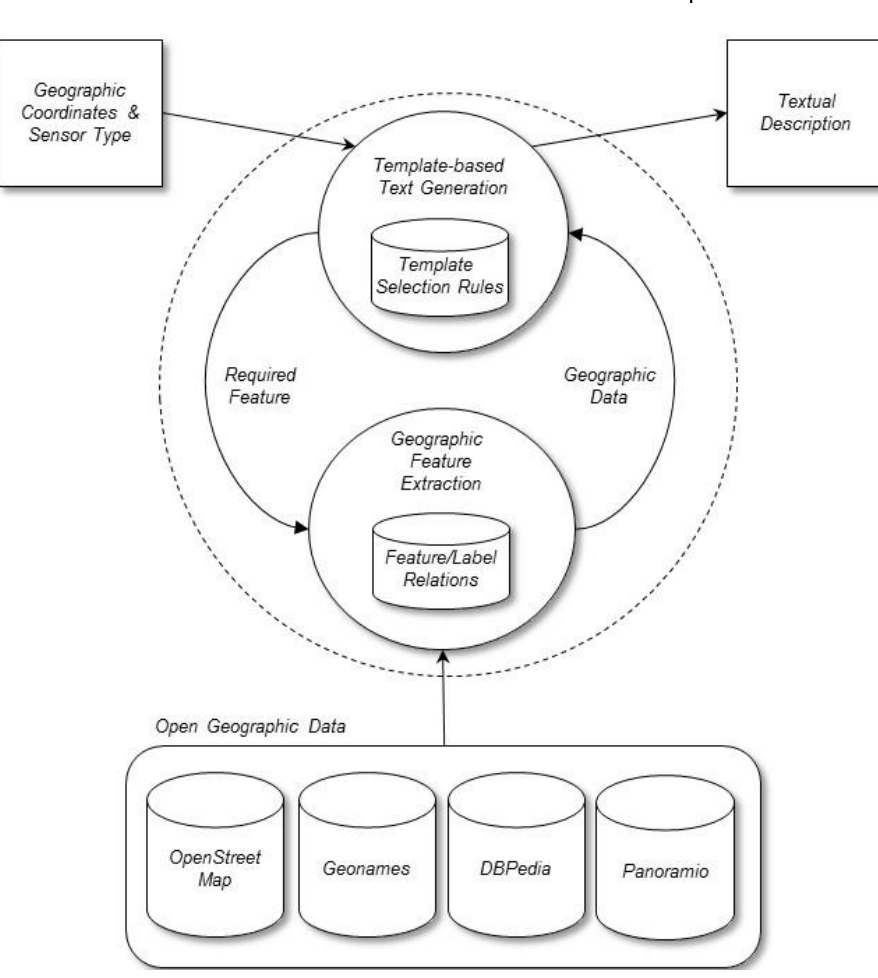
Figure 4. Main components of the